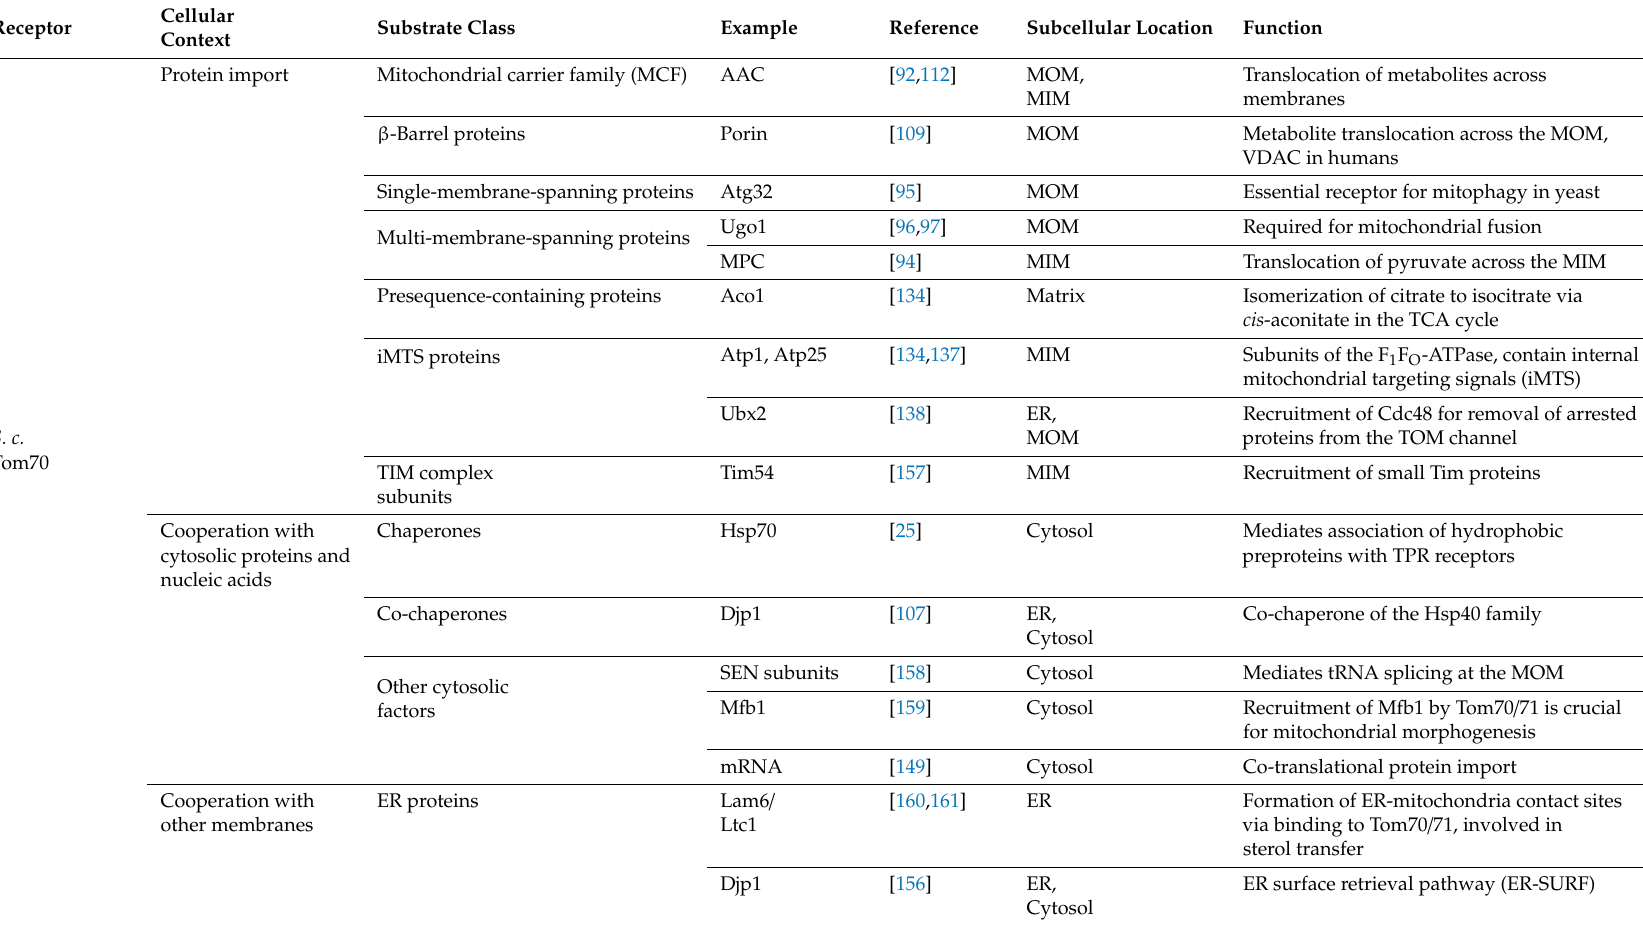
Table 1. Known substrates of Tom70. Listed are examples of proteins that were found to associate with Tom70 either directly or indirectly (e.g., through